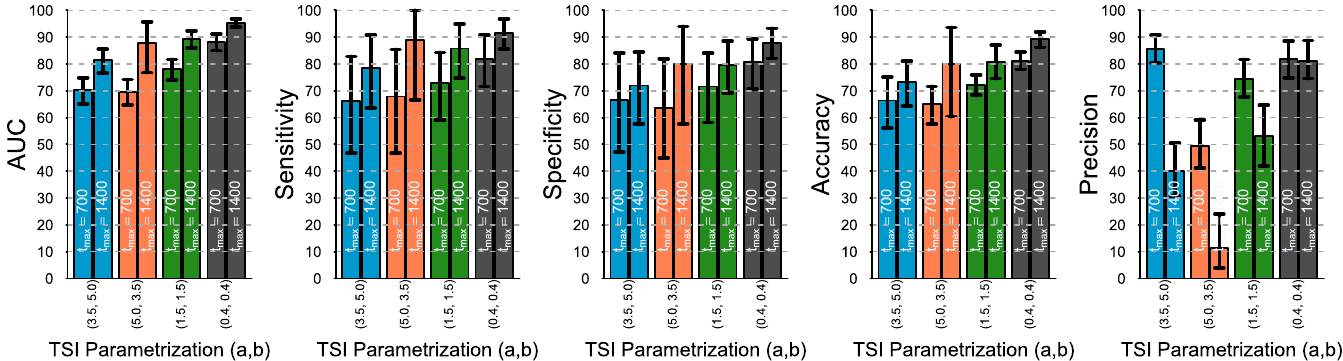
Fig 6. Comparing classification performance of the same assay with different TSI distribution and different ranges of TSI: 1 day up to t max = 700 days (left bars) and up to t max = 1400 days (right bars). With u = 0.2, sample size = 500, h = 500, recency at 365 days. The 95% prediction bounds are obtained from 1000 simulations.